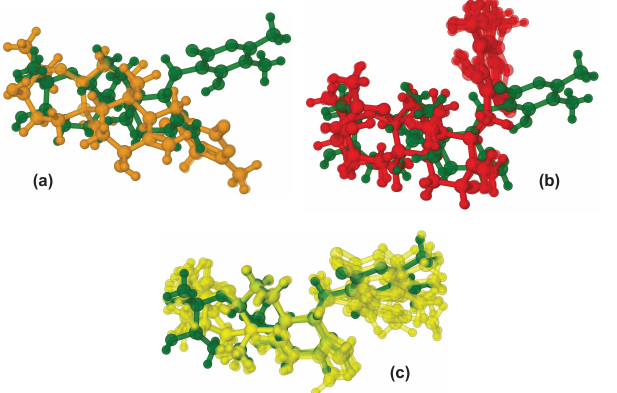
Figure 6. Superposition of the crystal structure of 3 (green) with the five best conformations obtained by ( a ) MD (orange), ( b ) long MD (red), and ( c ) DG with NOEs